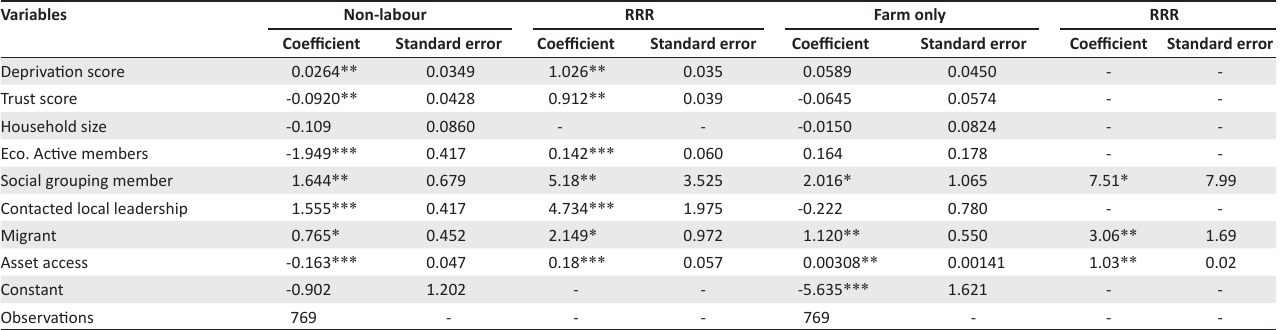
TABLE 13: Logistic regression results.